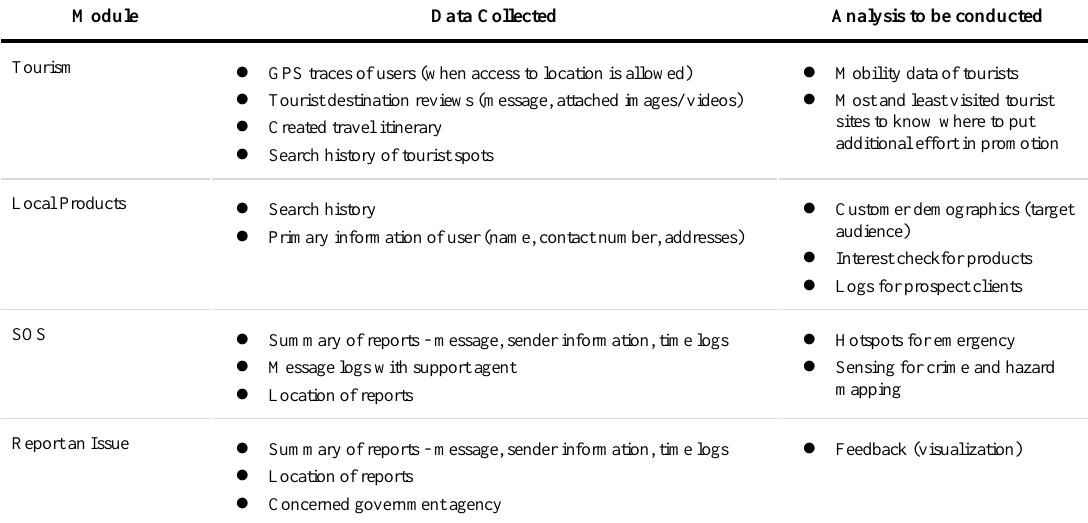
Table 1. List of data to be collected in each module